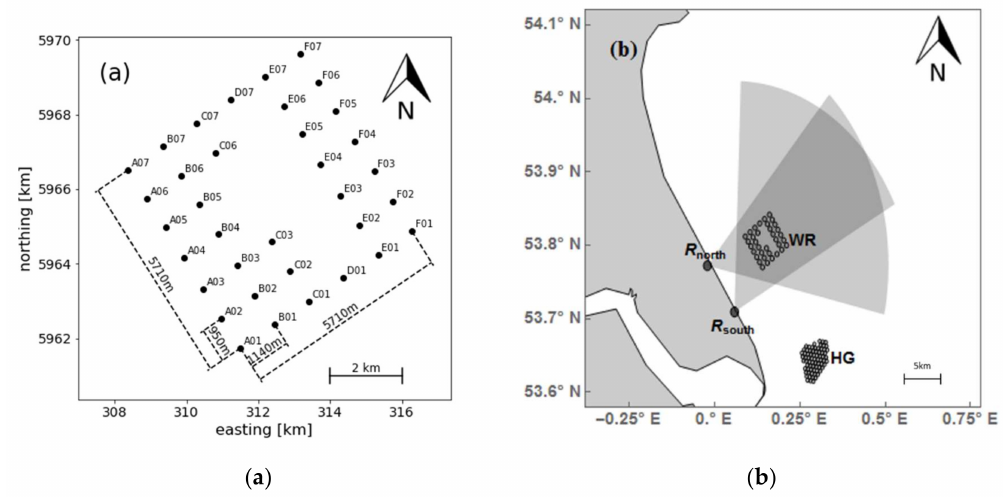
Figure 1. ( a ) Wind farm layout of Westermost Rough with six rows of turbines (A-F) and up to seven turbines in each row (01 to 07). ( b ) Overview of radar positions R north and R south and the areas covered by their scans. Two wind farms are present: Westermost Rough (WR) and Humber Gateway (HG).